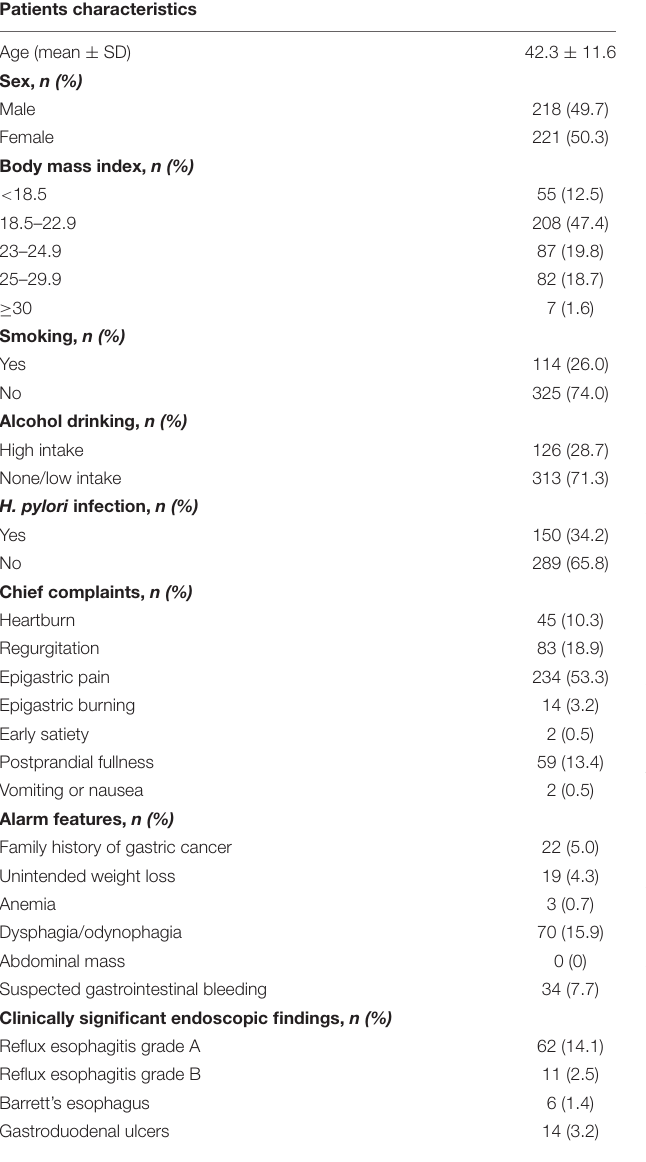
TABLE 1 | Demographic, clinical, and endoscopic characteristics of recruited patients.